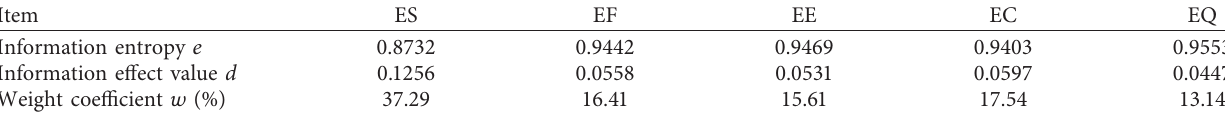
Table 3: Weight calculation results of the entropy method.